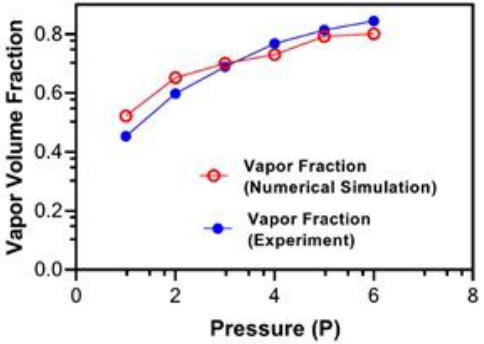
Figure 11: Validation for cavitation by numerical simulations against experimental data